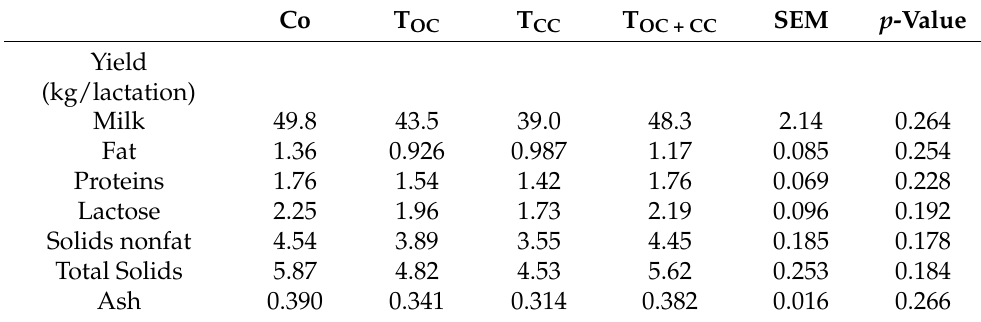
Table 4. Yield and composition per lactation of goat milk according to diet (n = 44).